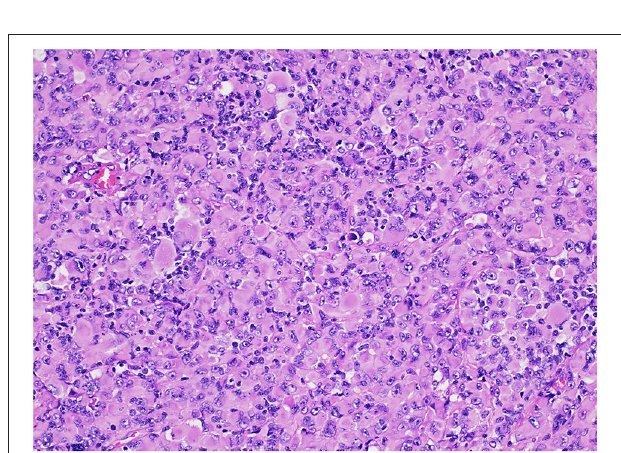
FIGURE 3 | Diffuse pediatric-type high-grade glioma, H3-wildtype and IDH-wildtype (“histologic epithelioid glioblastoma”) characterized by sheets of tumor cells with distinct nuclear borders, a moderate to large amount of eosinophilic cytoplasm, eccentrically-located nuclei, and prominent nucleoli. HandE stain, 200x